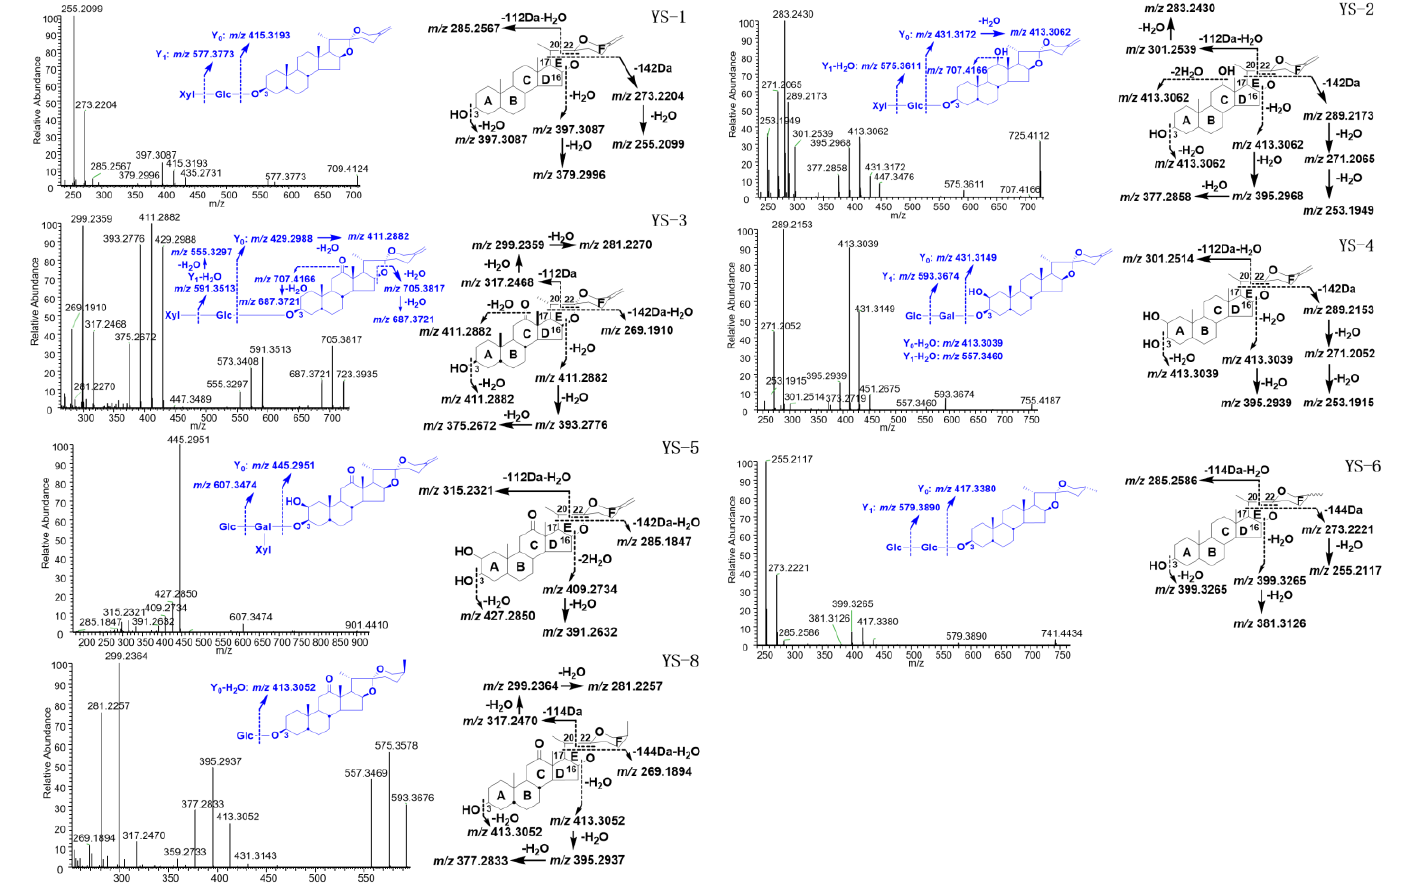
Figure 3. The MS/MS spectrum and proposed fragmentation pathways of YS ‑ 1 – YS-6 and YS-8. Figure 3. The MS / MS spectrum and proposed fragmentation pathways of YS-1–YS-6 and